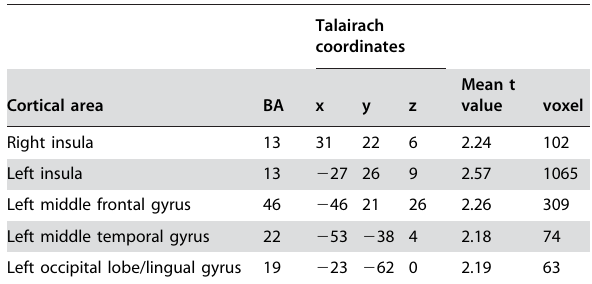
Table 2. Significant activity for the whole brain